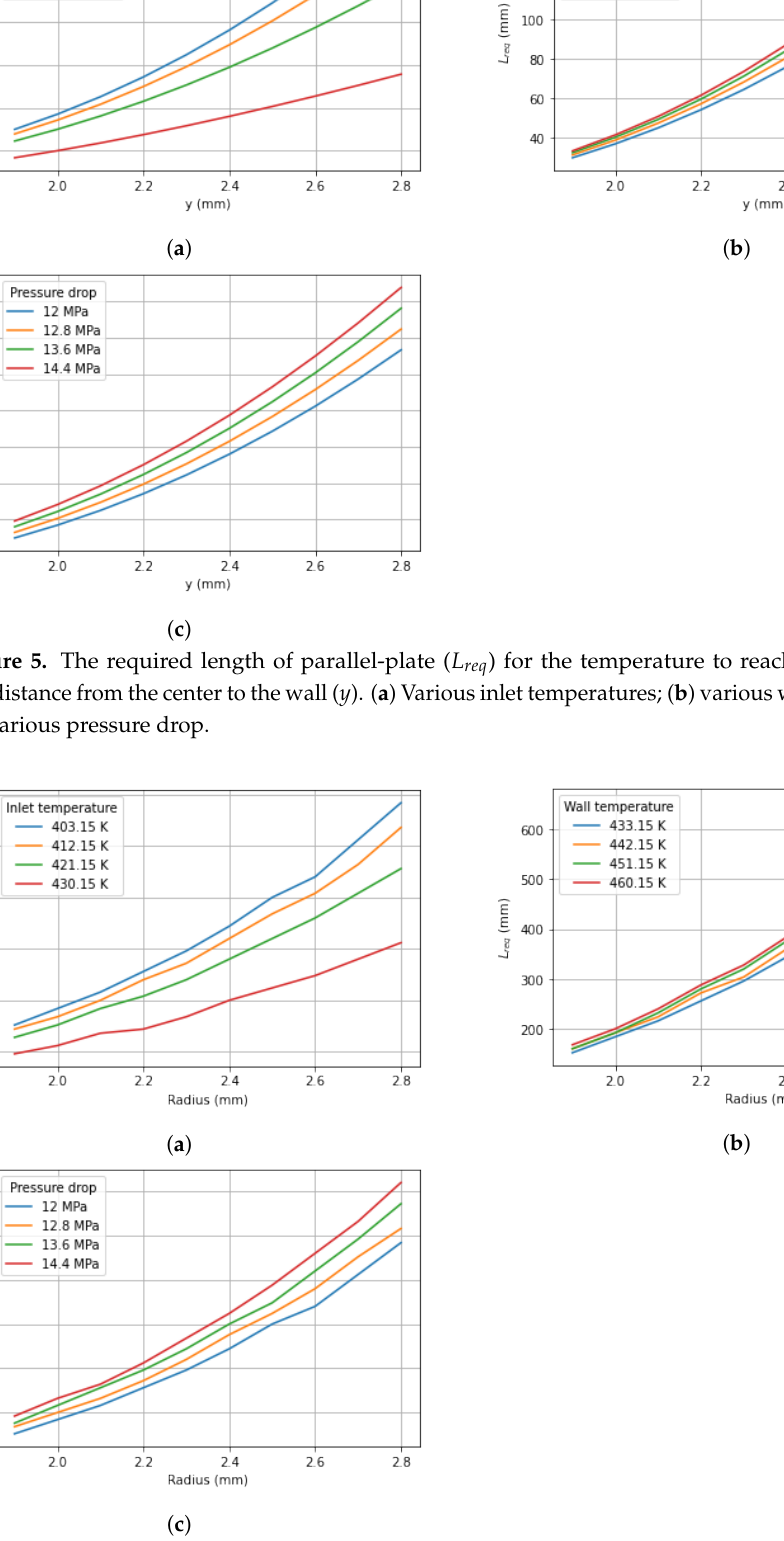
Figure 6. The required length of tube ( L req ) for the temperature to reach steady state vs. the radius of the tube. ( a ) Various inlet temperatures; ( b ) various wall temperatures; ( c ) various pressure